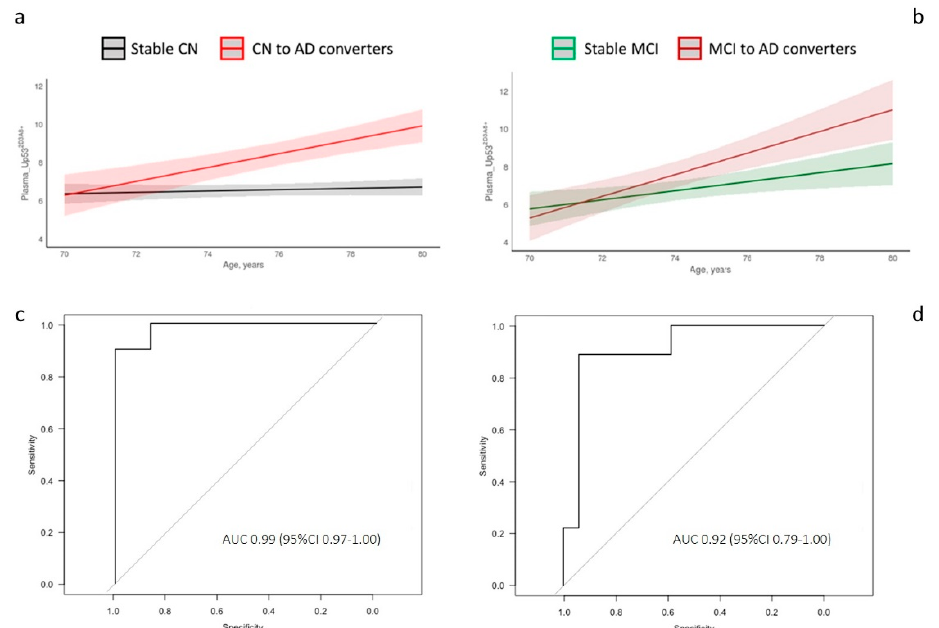
Figure 2. Longitudinal analysis and diagnostic accuracy of clinical Alzheimer’s disease of plasma_U-p53 2D3A8+ in InveCe.Ab. Linear mixed-effects (LME) was used to model U-p53 2D3A8+ levels across time and across disease progression in InveCe.Ab ( a , b ). ROC curves performed at T 2 after the conversion to decipher the accuracy of AD diagnosis ( c , d ). U-p53 2D3A8+ -discriminated Stable CN vs. CN-to-AD with specificity of 1.0 and sensitivity of 1.0 ( c ). U-p53 2D3A8+ -distinguished Stable MCI vs. MCI-to-AD with 0.94 specificity and 0.89 sensitivity ( d ). AUC, area under the curve. Figure S4 reports box and whiskers representation of U-p53 2D3A8+ across follow-up (baseline, T 1 , and T 2 ) and disease stratification (CN-Stable, CN to MCI, and CN to AD on the left and MCI Stable and MCI to AD on the right). Results were extrapolated from a short-reference peptide standard curve and are expressed in arbitrary units (a.u.).